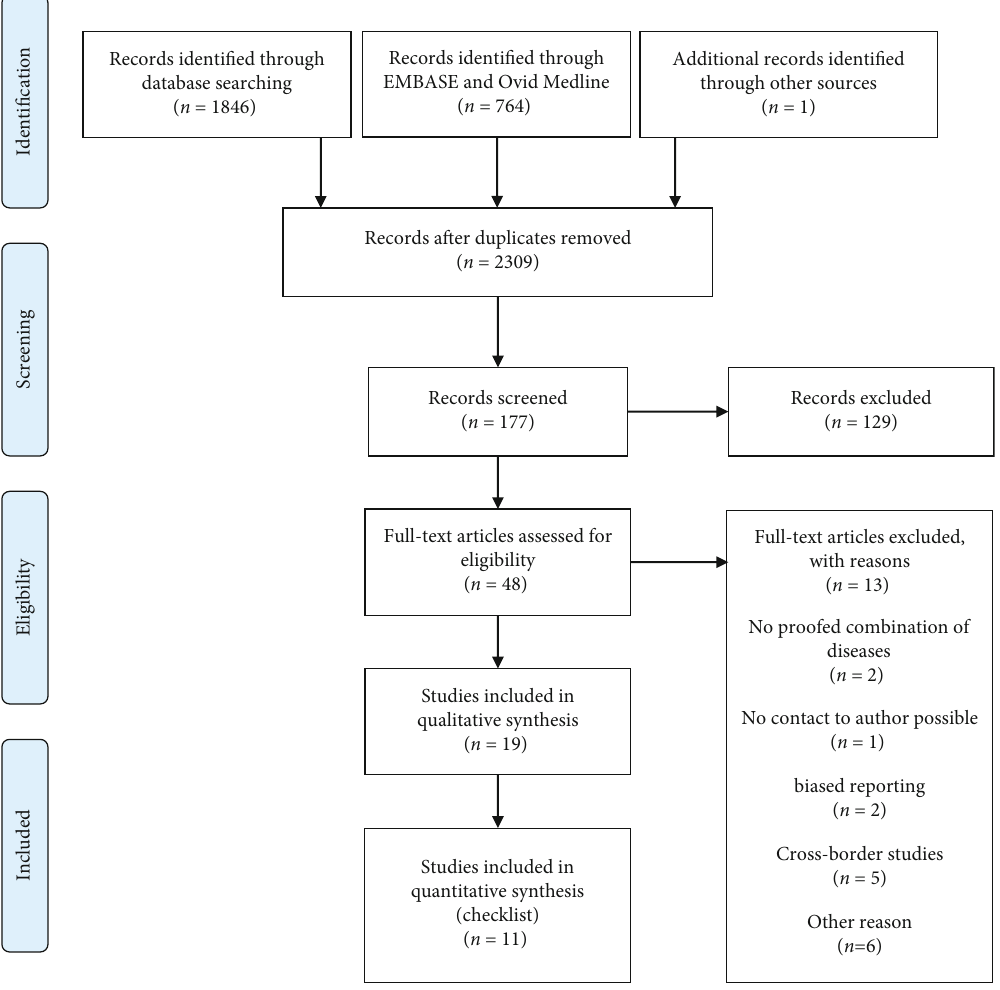
Figure 2: PRISMA fl ow diagram for searching strategy